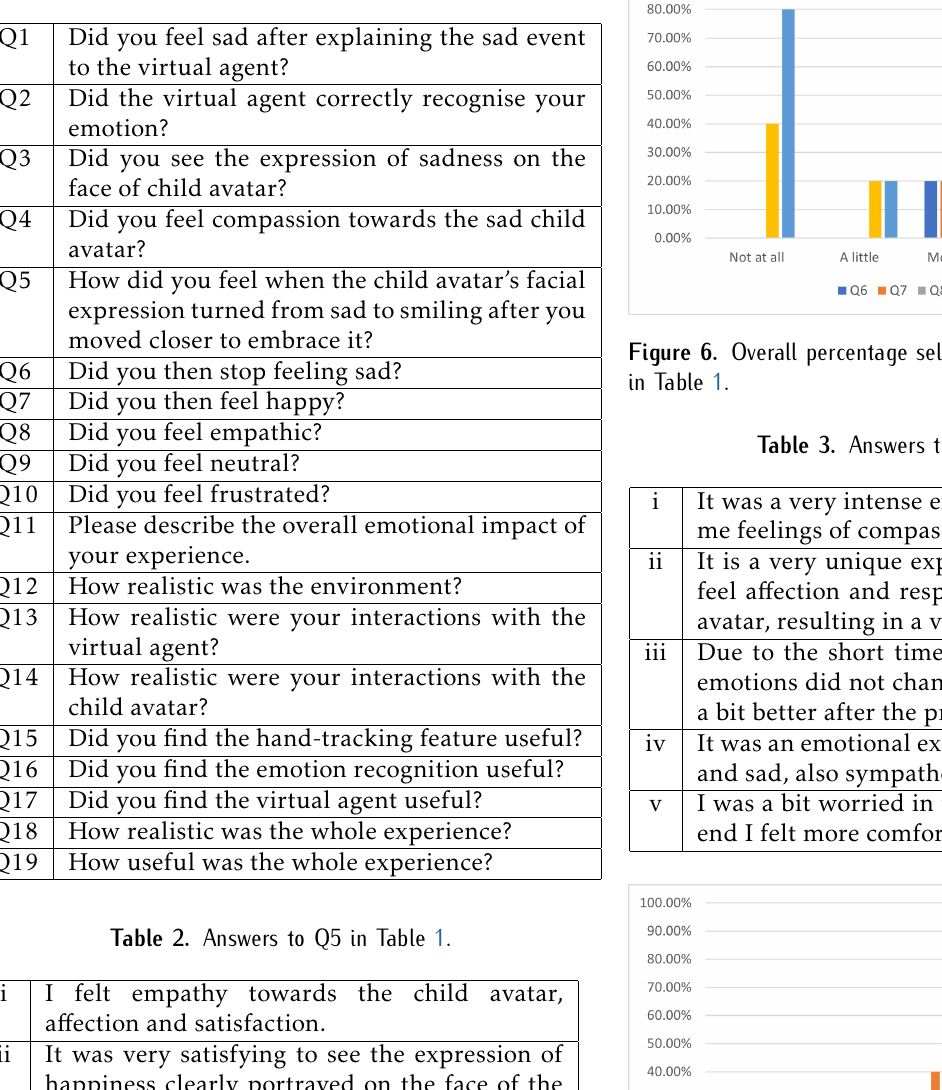
Table 1. Likert scale (N=5) questionnaire: Trial with customised child avatar.